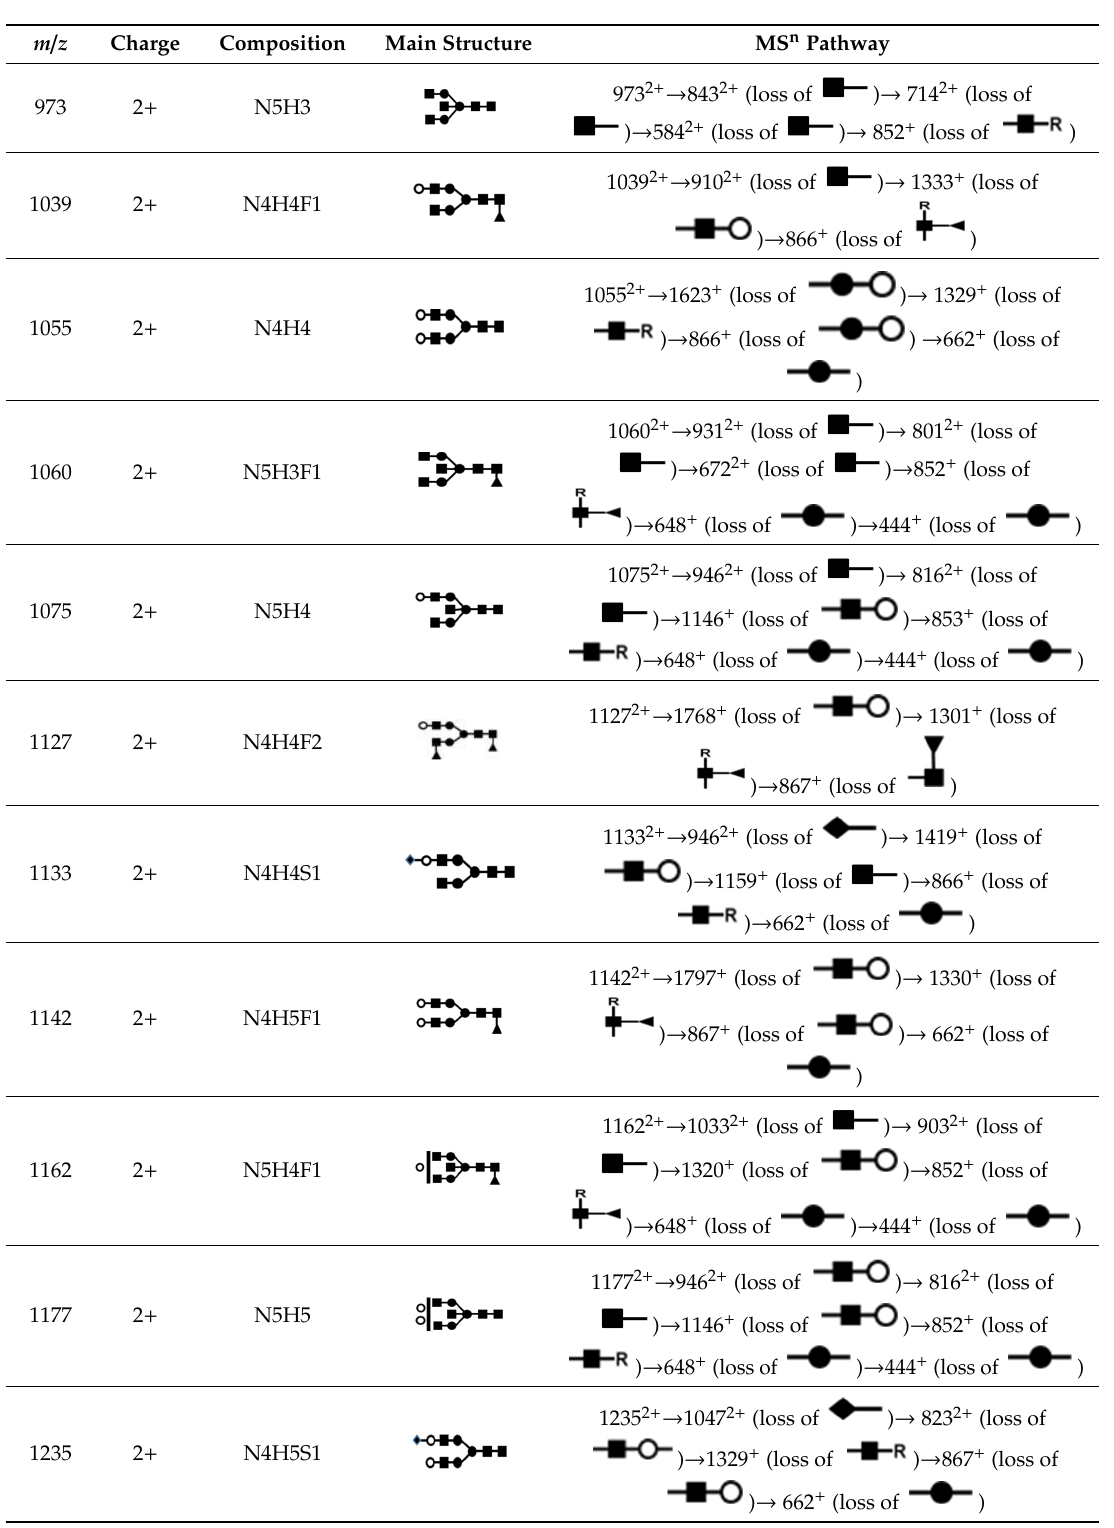
Table 1. Major N-glycans in sera of healthy controls and rheumatoid arthritis patients.